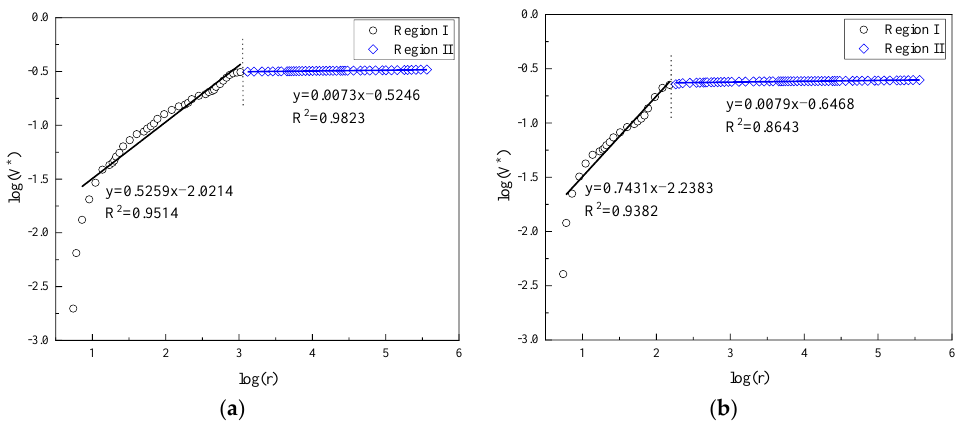
Figure 12. Multifractal characteristics of CCP10 at different ages under Ji’s model. ( a ) 3 days, ( b ) 28 days.